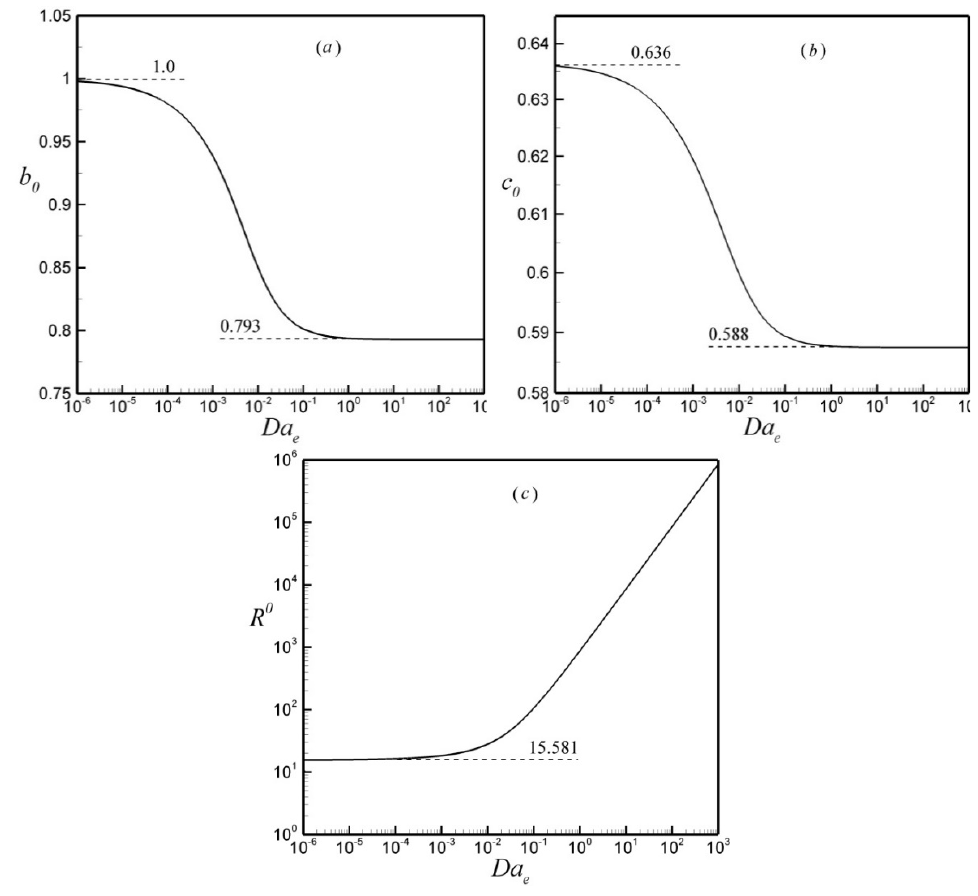
Figure 3. The effect of Da e on ( a ) b 0 , ( b ) c 0 , and ( c ) R 0 for an infinite layer A → ∞